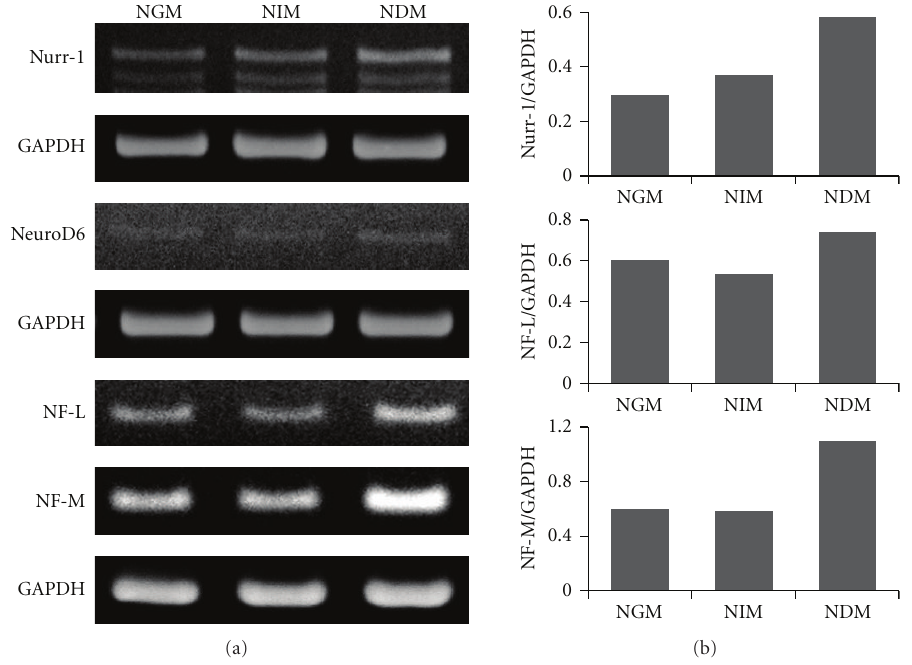
Figure 3: Neuron-specific gene expression of hMSCs during neural di ff erentiation. (a) Cells that had been harvested 6 hr for Nurr-1, 12hr for NeuroD6, and 48hr for NF-L and NF-M were used in RT-PCR assay. NGM: normal growth media; NIM: neural induction media; NDM: neural di ff erentiation media. (b) The relative expression of Nurr-1, NF-L, and NF-M was normalized by GAPDH using densitometric analysis. Data for NeuroD6 were omitted because bands corresponding to NeuroD6 were too faint to be measured by densitometry.